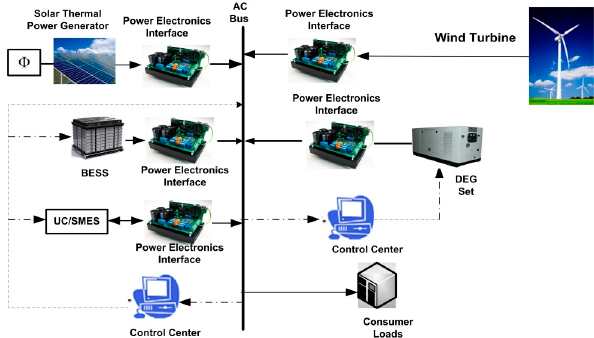
Figure 1. Conceptual wind–solar thermal power generation (STPG)–diesel–battery energy storage system (BESS)–ultracapacitor (UC) / super magnetic energy storage (SMES)-based autonomous hybrid energy